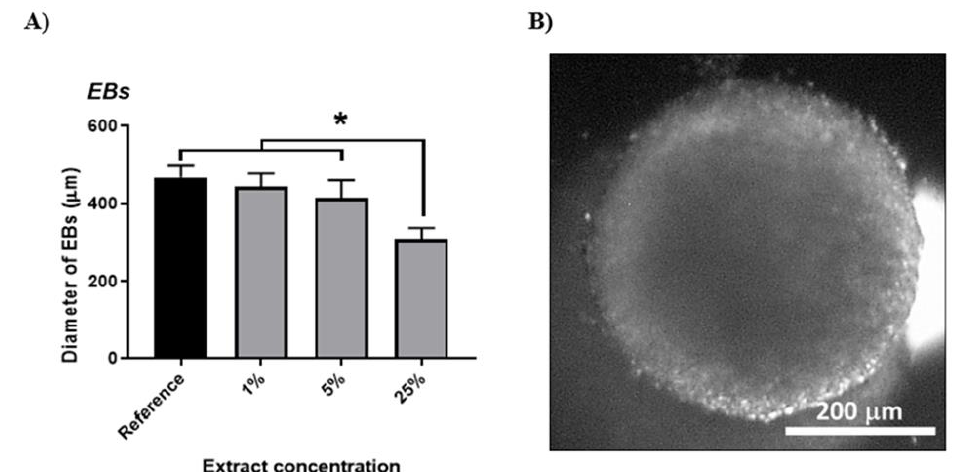
Figure 4. ( A ) Cytotoxic effect of PPy extract on embryoid bodies (EBs). The size of EBs determined on Day 5 of culture. ( B ) Embryonic body. Data are reported as the mean and standard deviations from a minimum of four independent experiments. Statistical significance was determined by ANOVA with post hoc Tukey’s Multiple Comparison test; * p < 0.05.